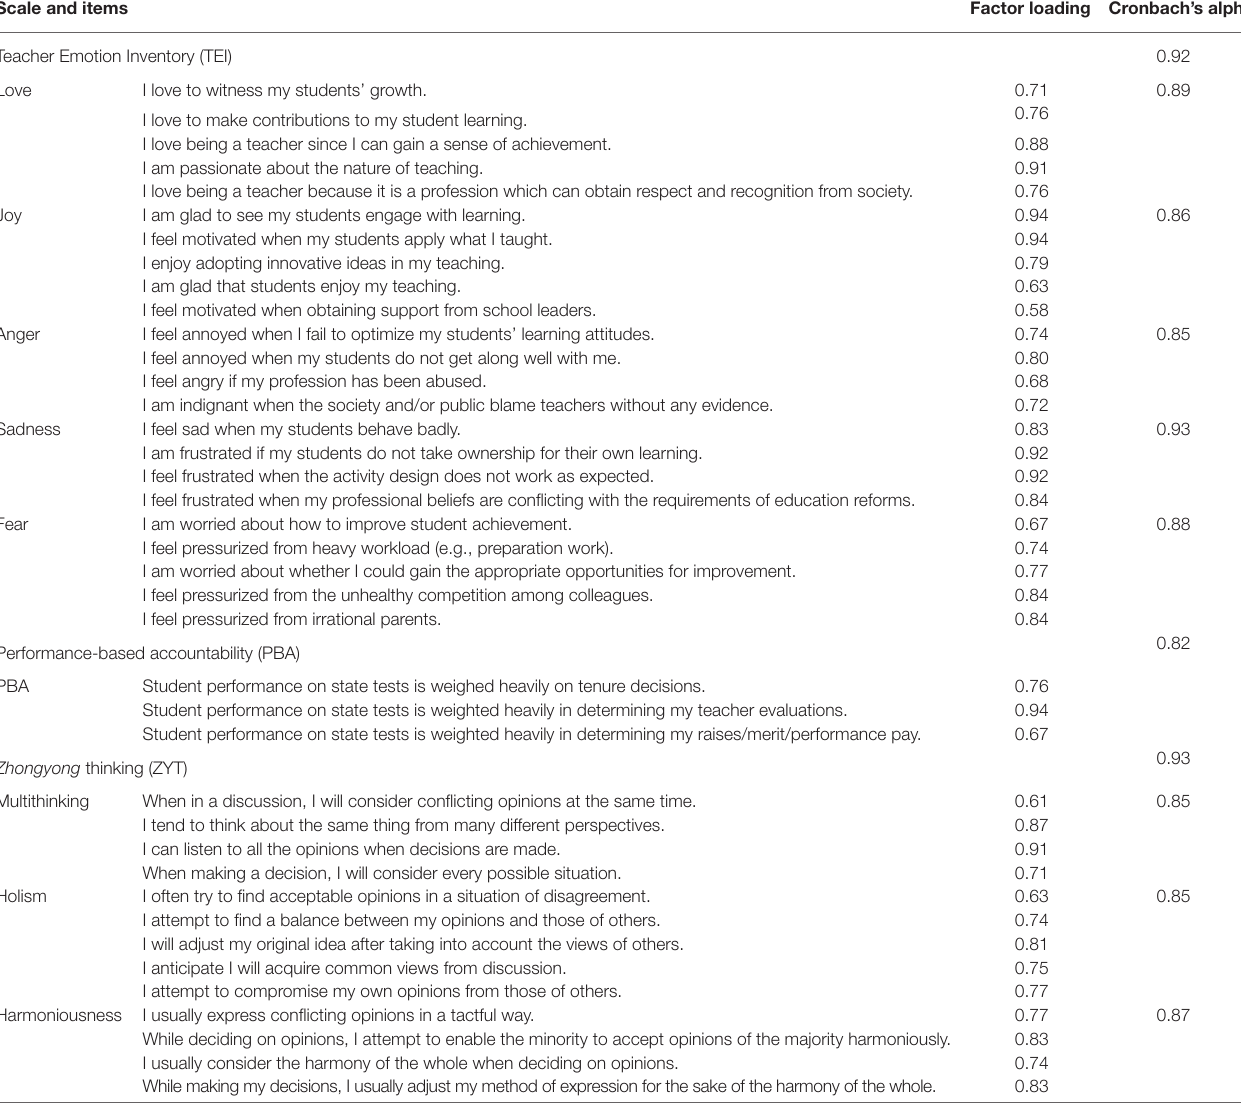
TABLE 2 | Teacher Emotion Inventory (TEI), performance-based accountability (PBA), and Zhongyong thinking (ZYT) factors, items, and factor loadings. Scale and items Factor loading Cronbach’s alpha Teacher Emotion Inventory